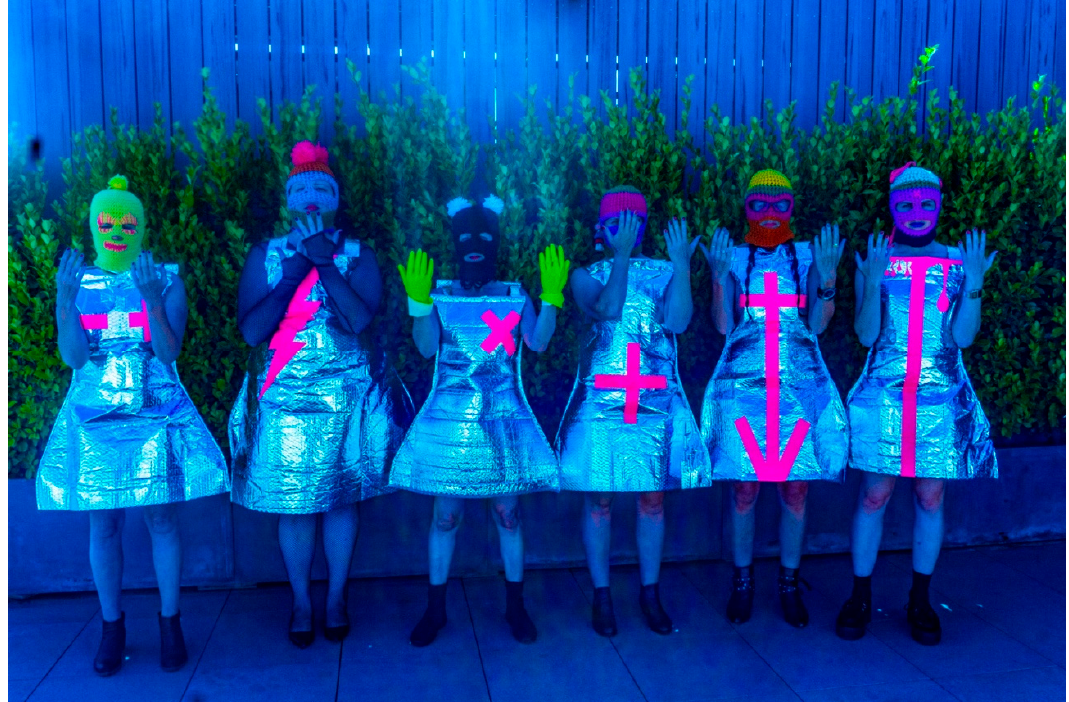
Figure 9. Sonic Electric sound performance collective led and choreographed by Juliana España Keller 2019.